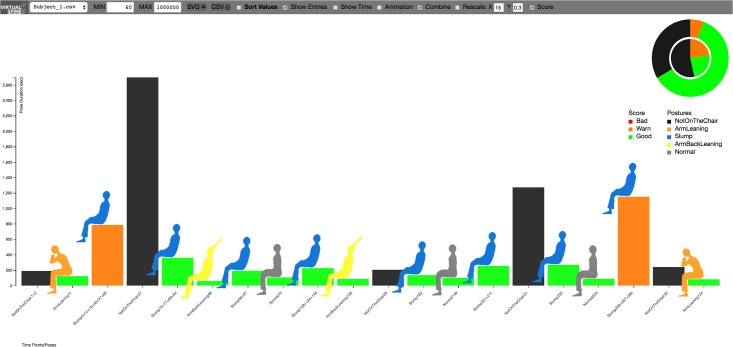
VSP-ADV with scoring posture-dependent coloring.Score colors, in this mode represented by the bars: Green: good with d ≤ 8 min., Orange: warn with 8 min. < d ≤ 20 min., Red: bad with 20 min. < d. Subject 1 showed a quite good sitting behavior, as no red warning is shown at all. Please see also the caption of Fig 5.